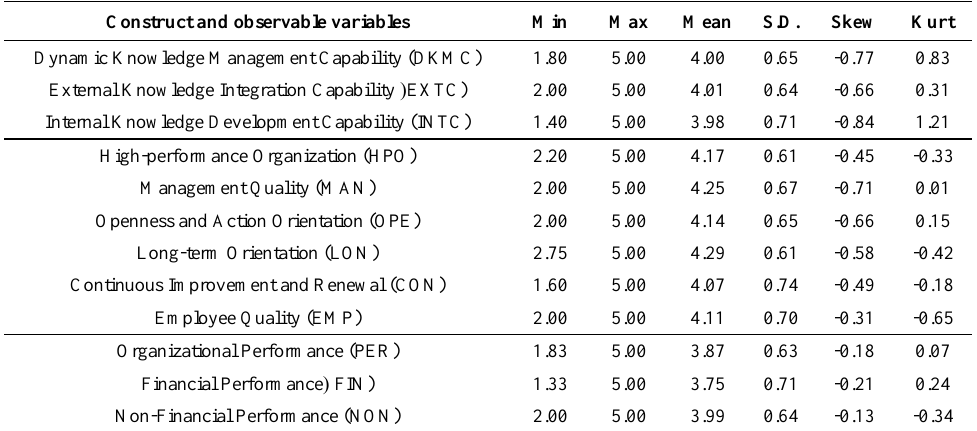
Table 1. Basic statistics of the variables on the factors of dynamic knowledge management capability, HPO, and organizational performance